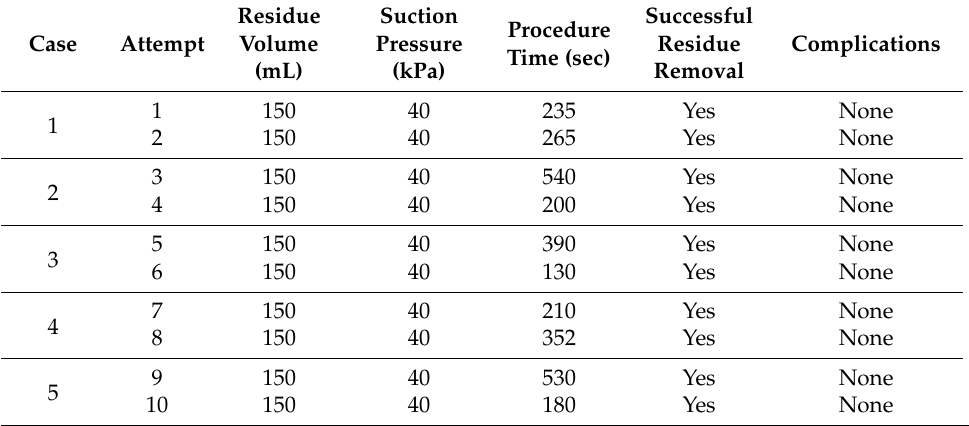
Table 3. Results of the endoscopic gastric residue removal method in a total of 10 attempts in 5 beagle